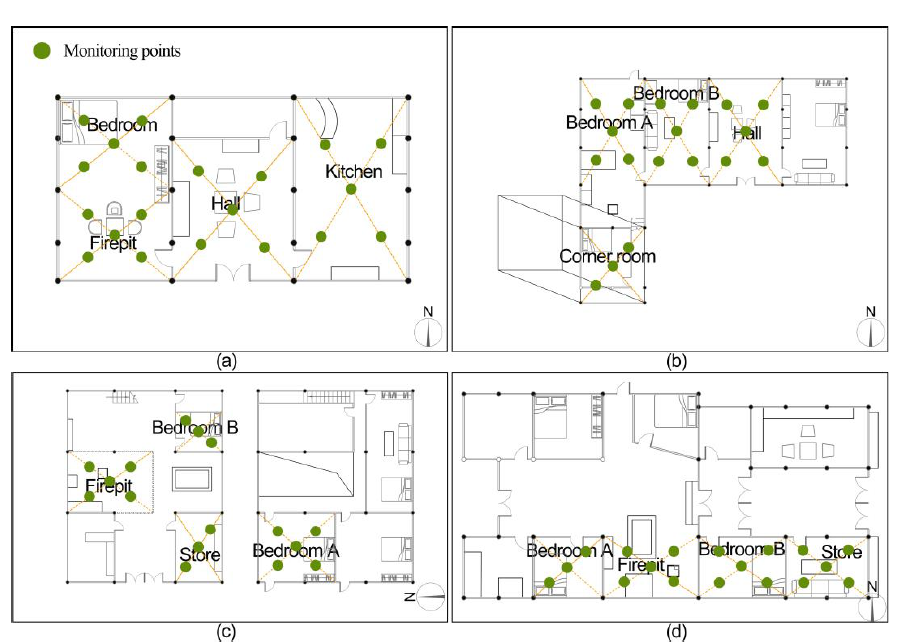
Table 4. Situation of monitored residential houses.